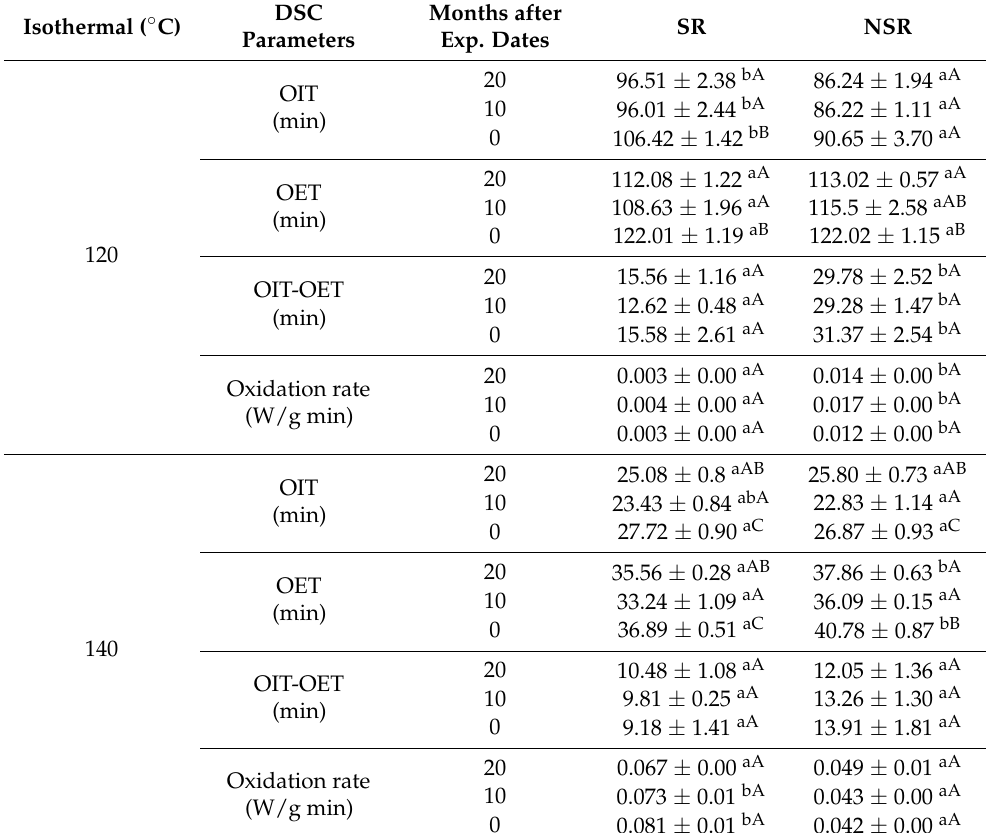
Table 2. Oxidative stability of raspberry seed oil based on DSC isothermal parameters (120 ◦ C and 140 ◦